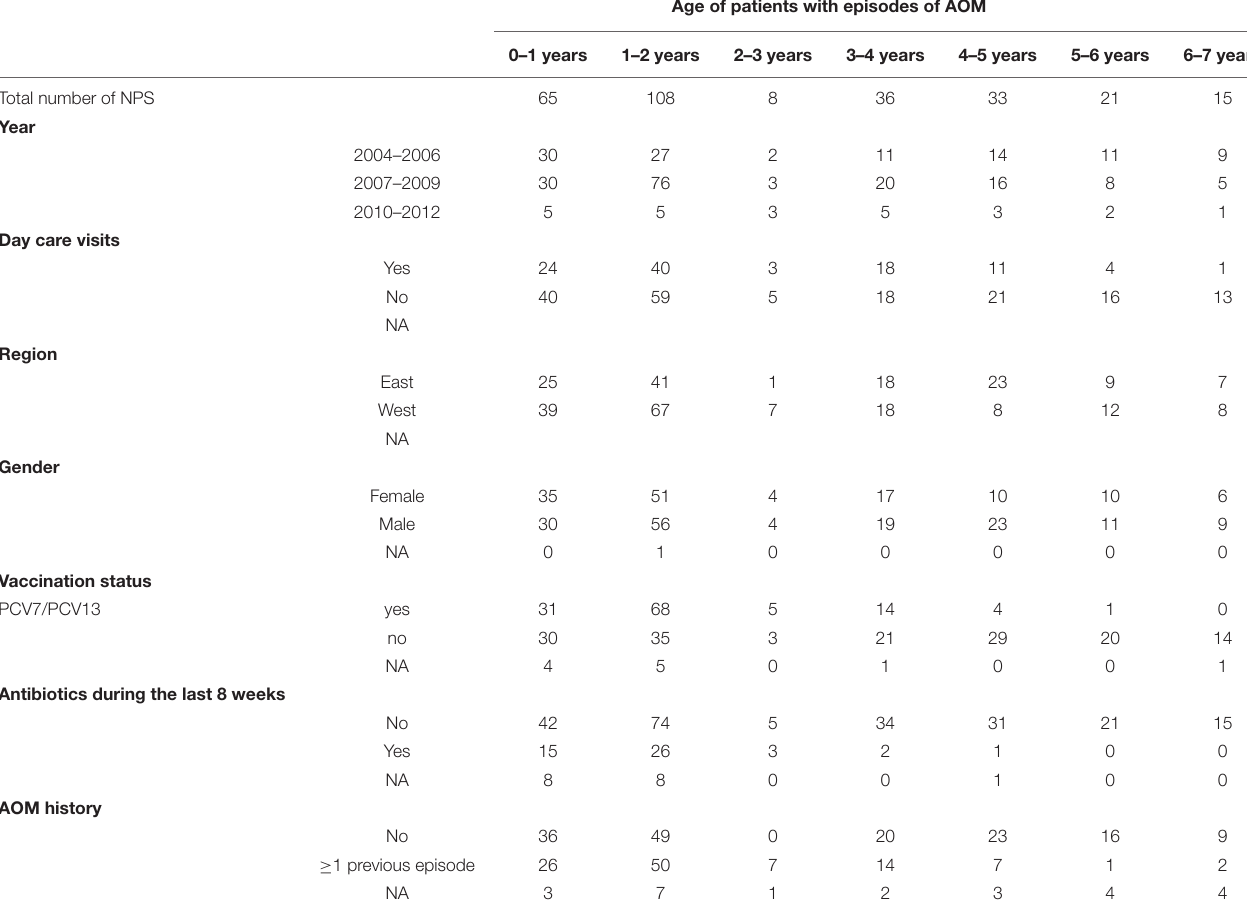
TABLE 1 | Overview of study